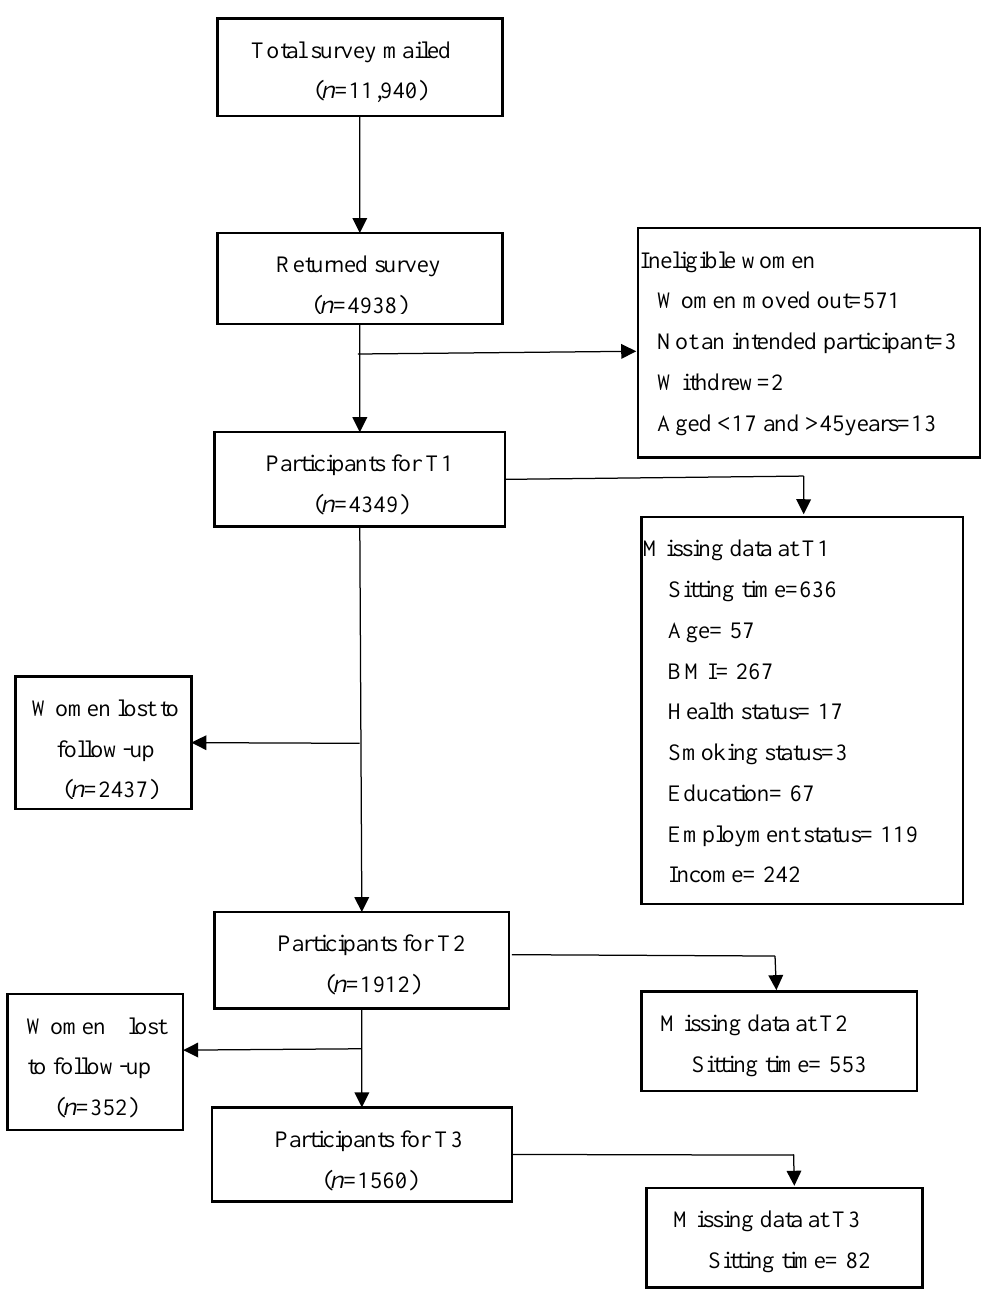
Figure 1. Flow chart of READI